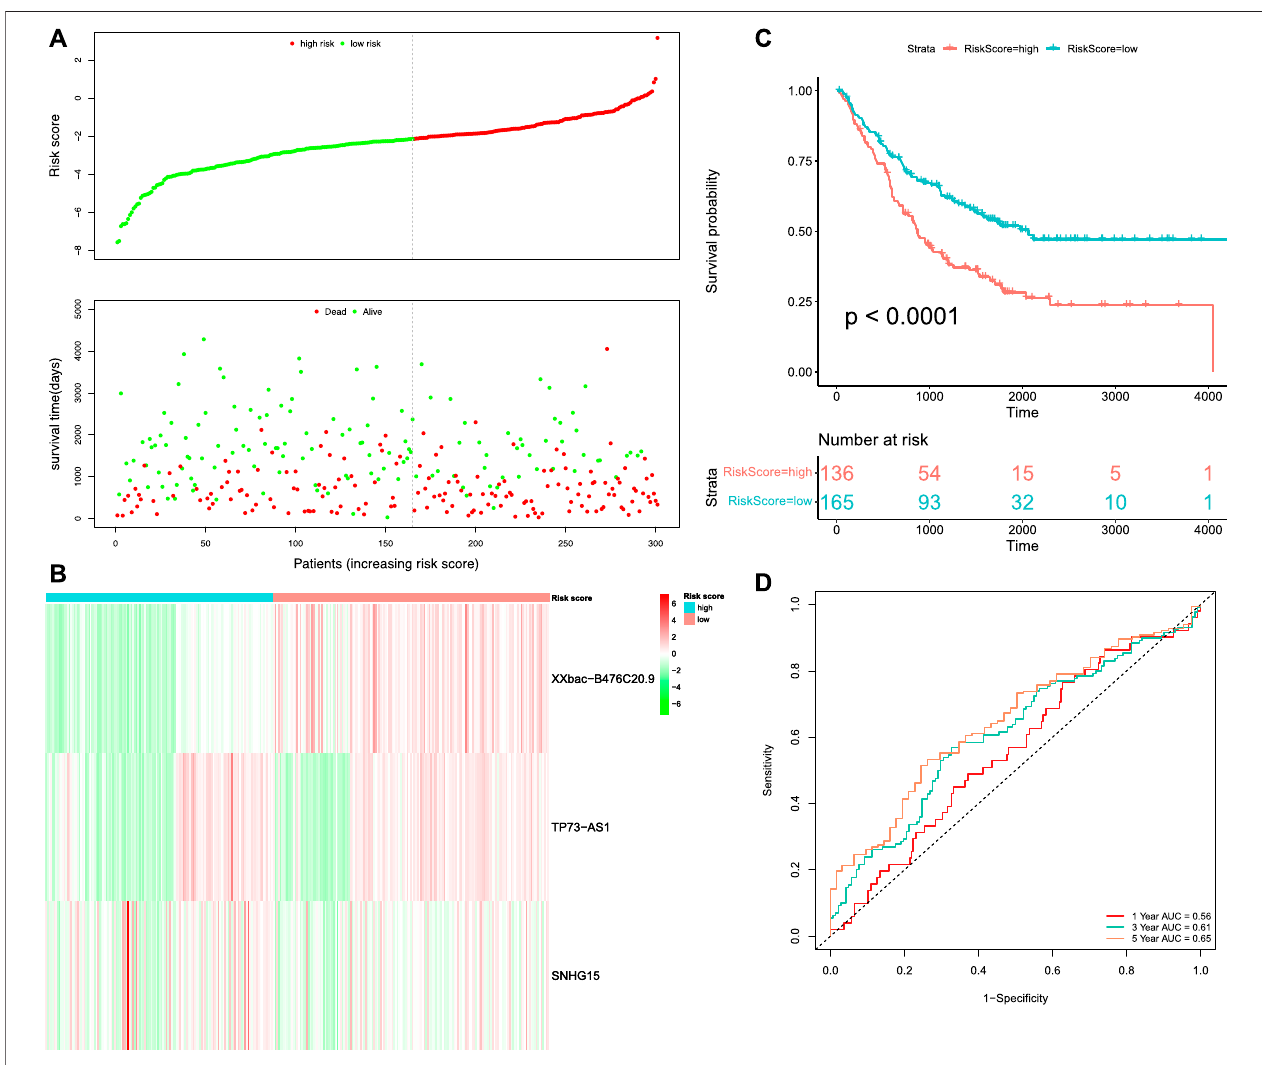
FIGURE 7 | Survival and time-dependent ROC curve analysis of the prognostic model in the validation set. (A) Risk score distribution and survival status of the patients. (B) Heatmap of three DEFR-lncRNAs. (C) Kaplan – Meier curve analysis of the OS between high-risk and low-risk groups. (D) Time-dependent ROC curve analysis of the